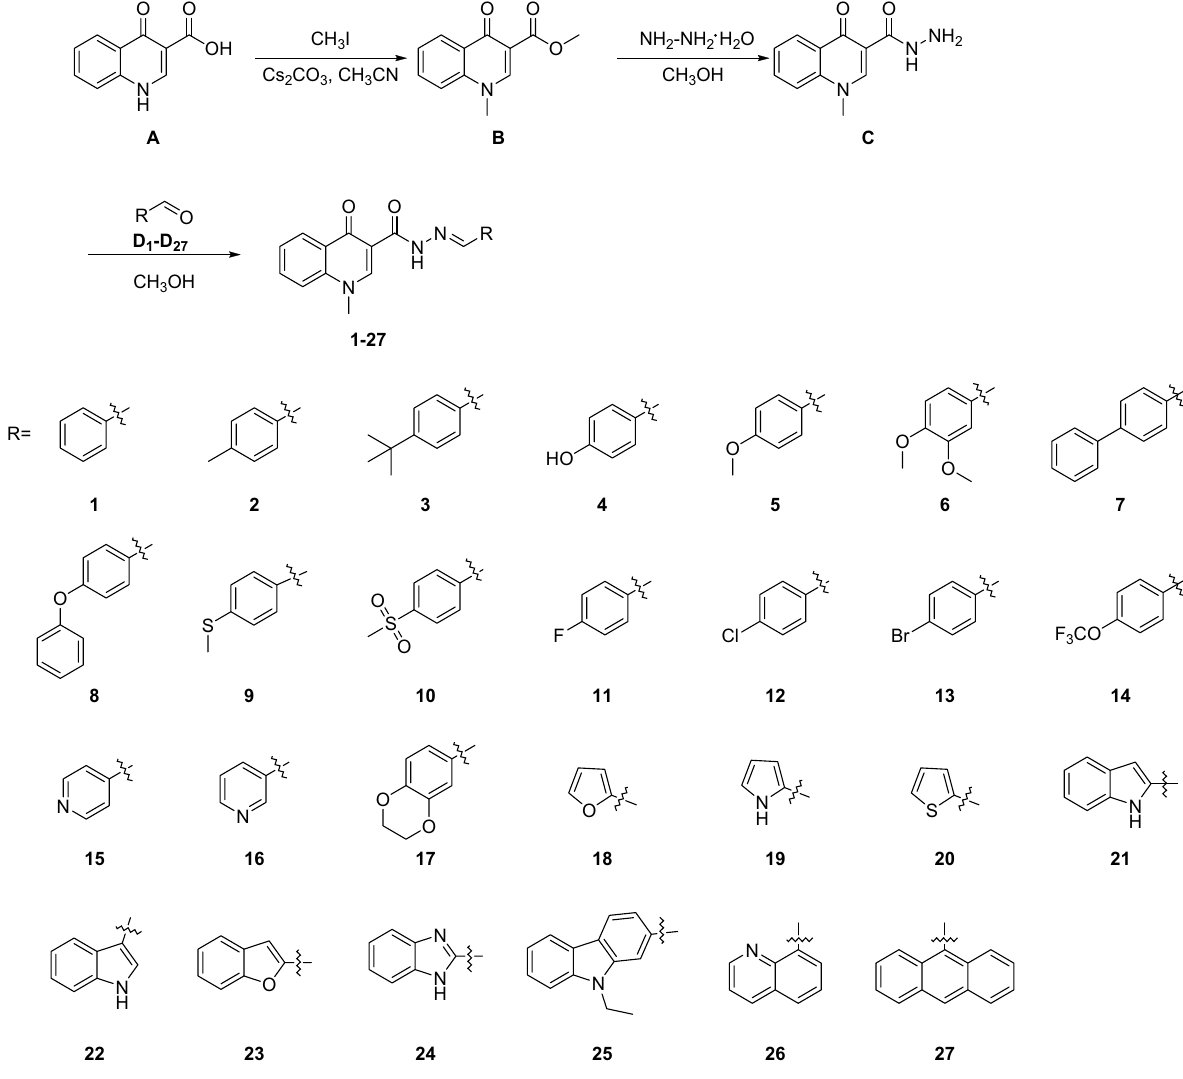
Figure 3. Synthesis of echinopsine acylhydrazone